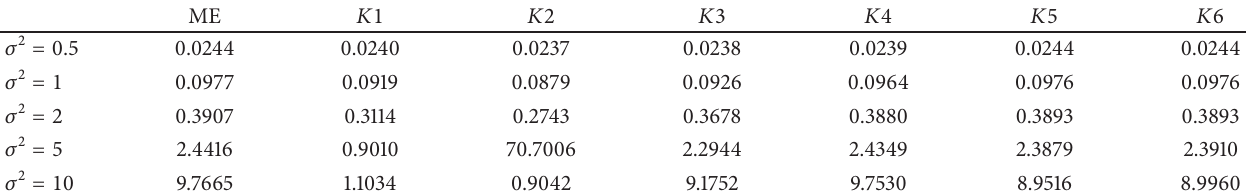
Table 4: Estimated MSE with 𝑛 = 50 , 𝑝 = 4 , and 𝛾 = 0.99